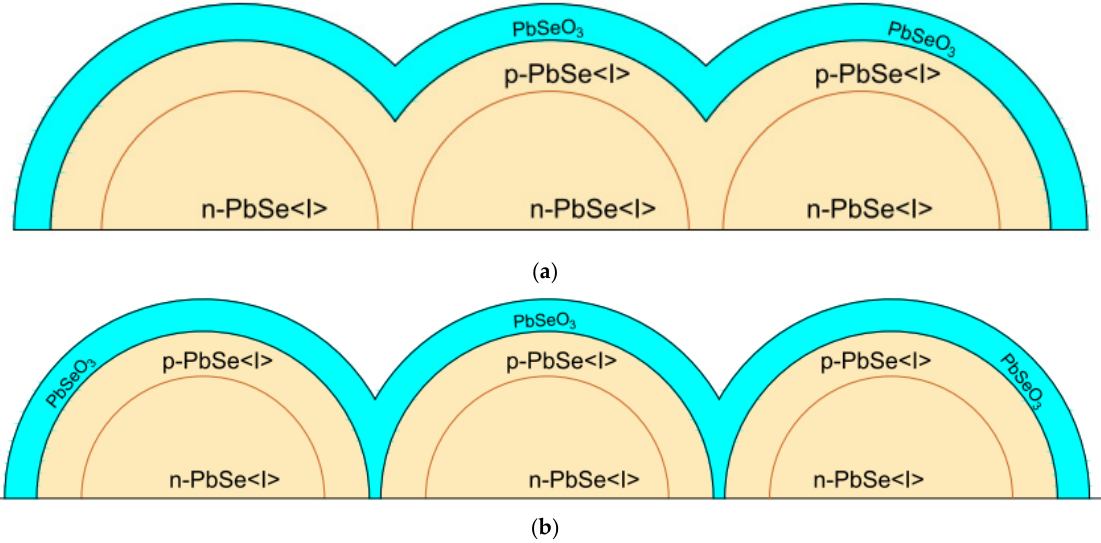
Figure 7. Diagram of a constricting percolation cluster for a p-layer with a rupture of the flow along n-regions in the architectonics of the photodetector ( a ) and the architectonics of the emitter—the paths of the flow are broken as in n-layers and along the p-layers ( b ).